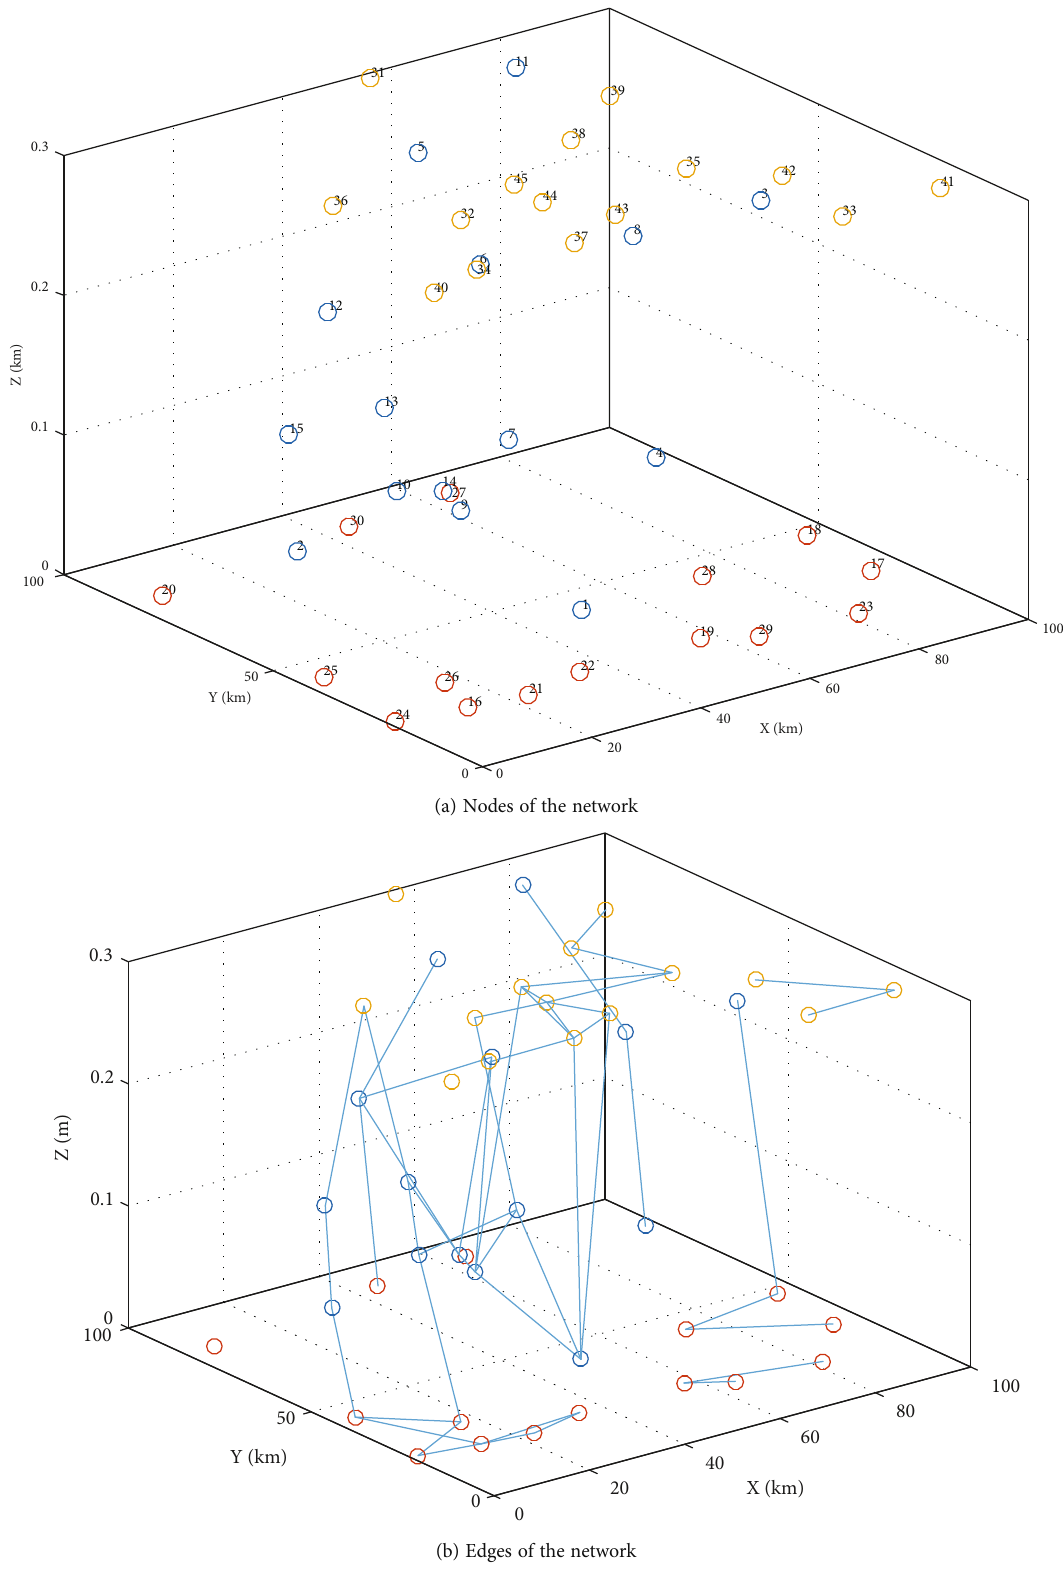
Figure 11: 3D fl ight con fl ict